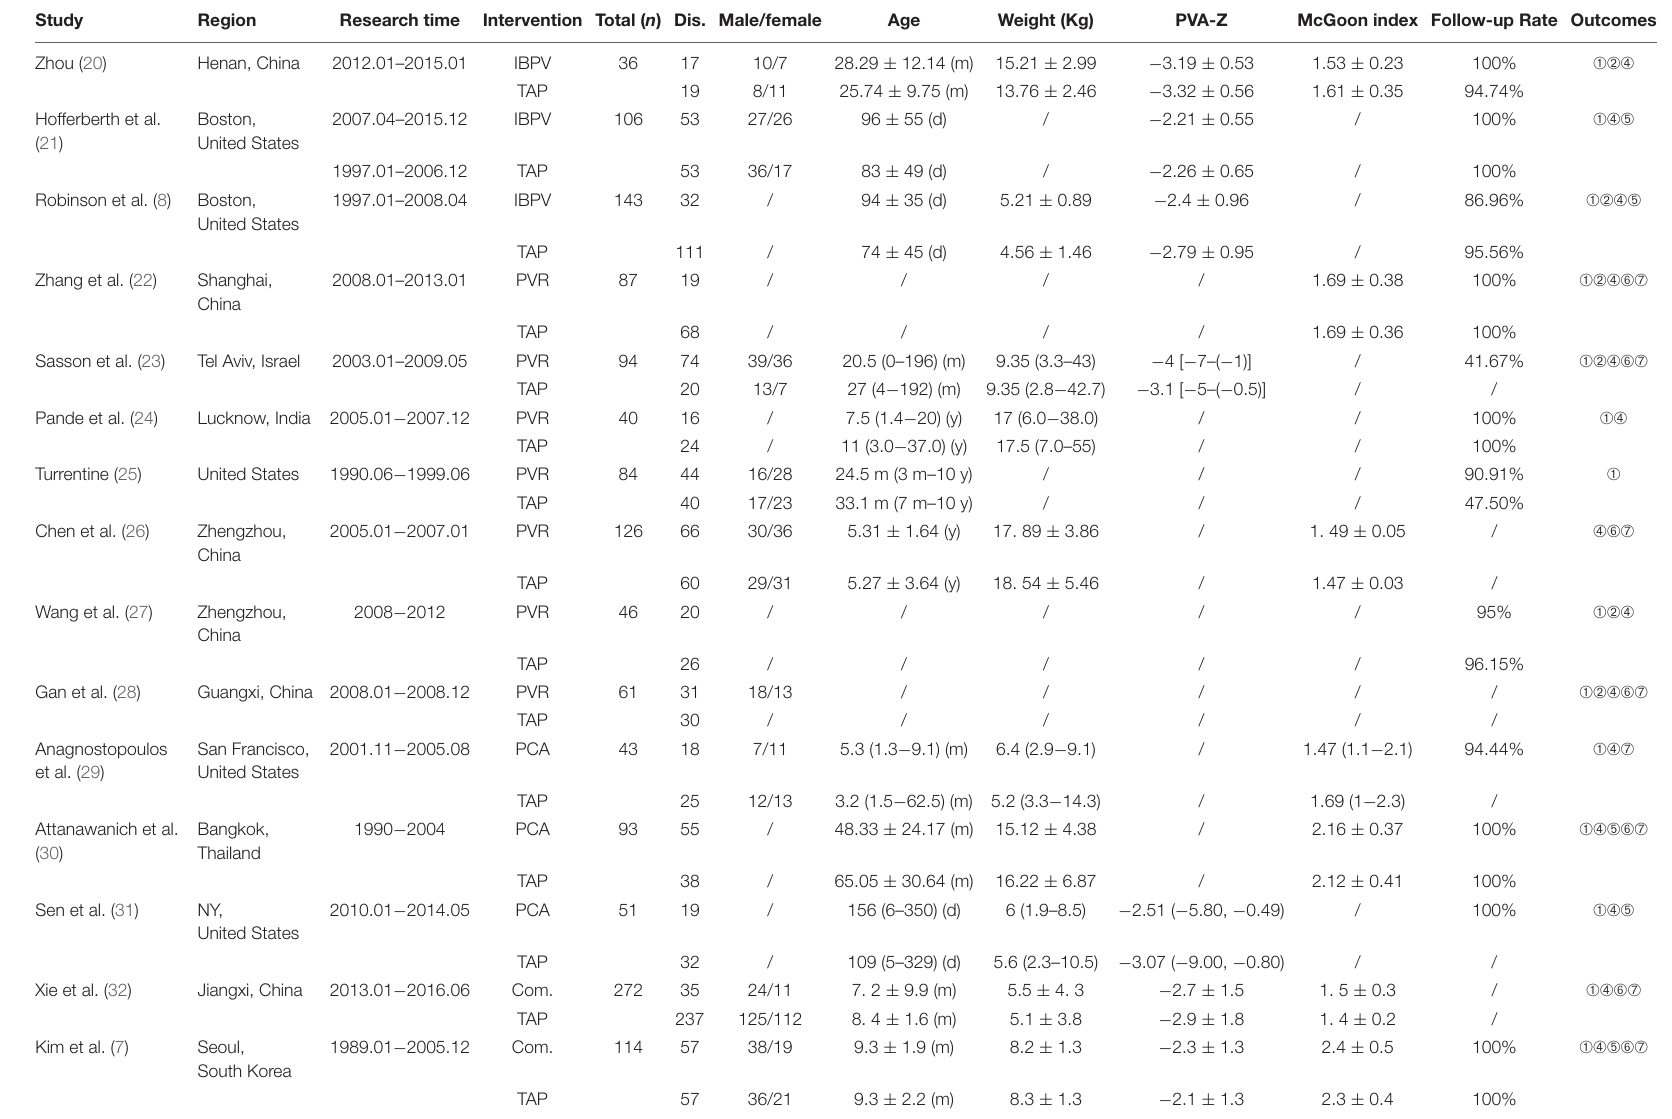
TABLE 1 | Characteristics of included studies in the